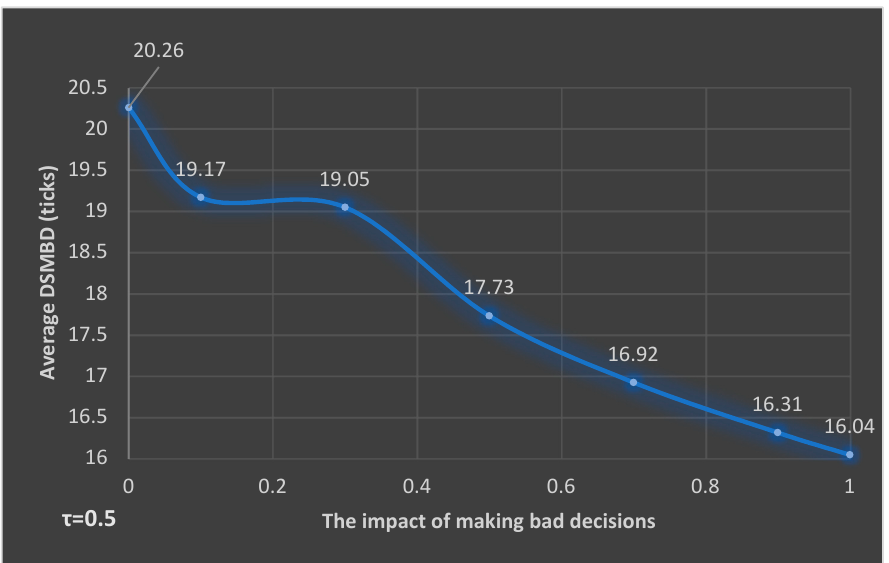
Figure 7. Average DSMBD versus the impact of making bad decisions, when τ = 0.5 and S1 is considered.